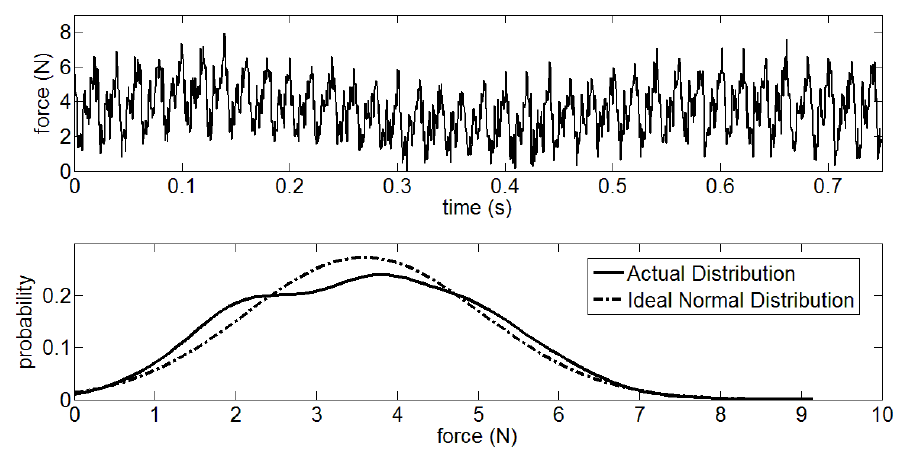
Figure 4. Data analysis of normal distribution for GCF in unstable area.